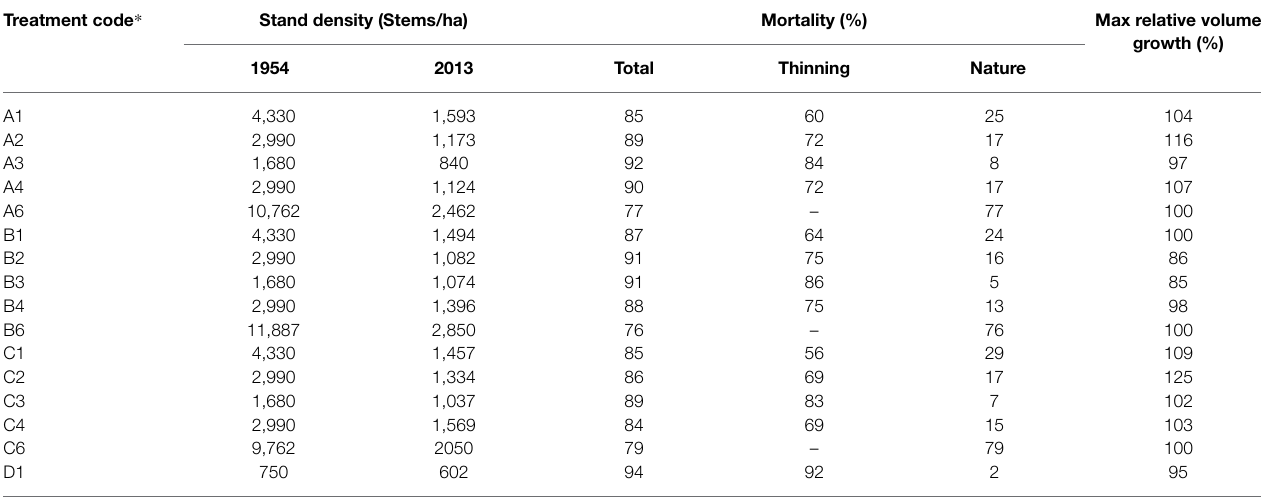
TABLE 2 | Stand density, mortality, and maximal relative volume growth of the MacKay thinning trial in Alberta, Canada, in which naturally regenerated lodgepole pine ( Pinus contorta Douglas) stands were submitted to a gradient of pre-commercial thinning intensity. Treatment code * Stand density (Stems/ha)